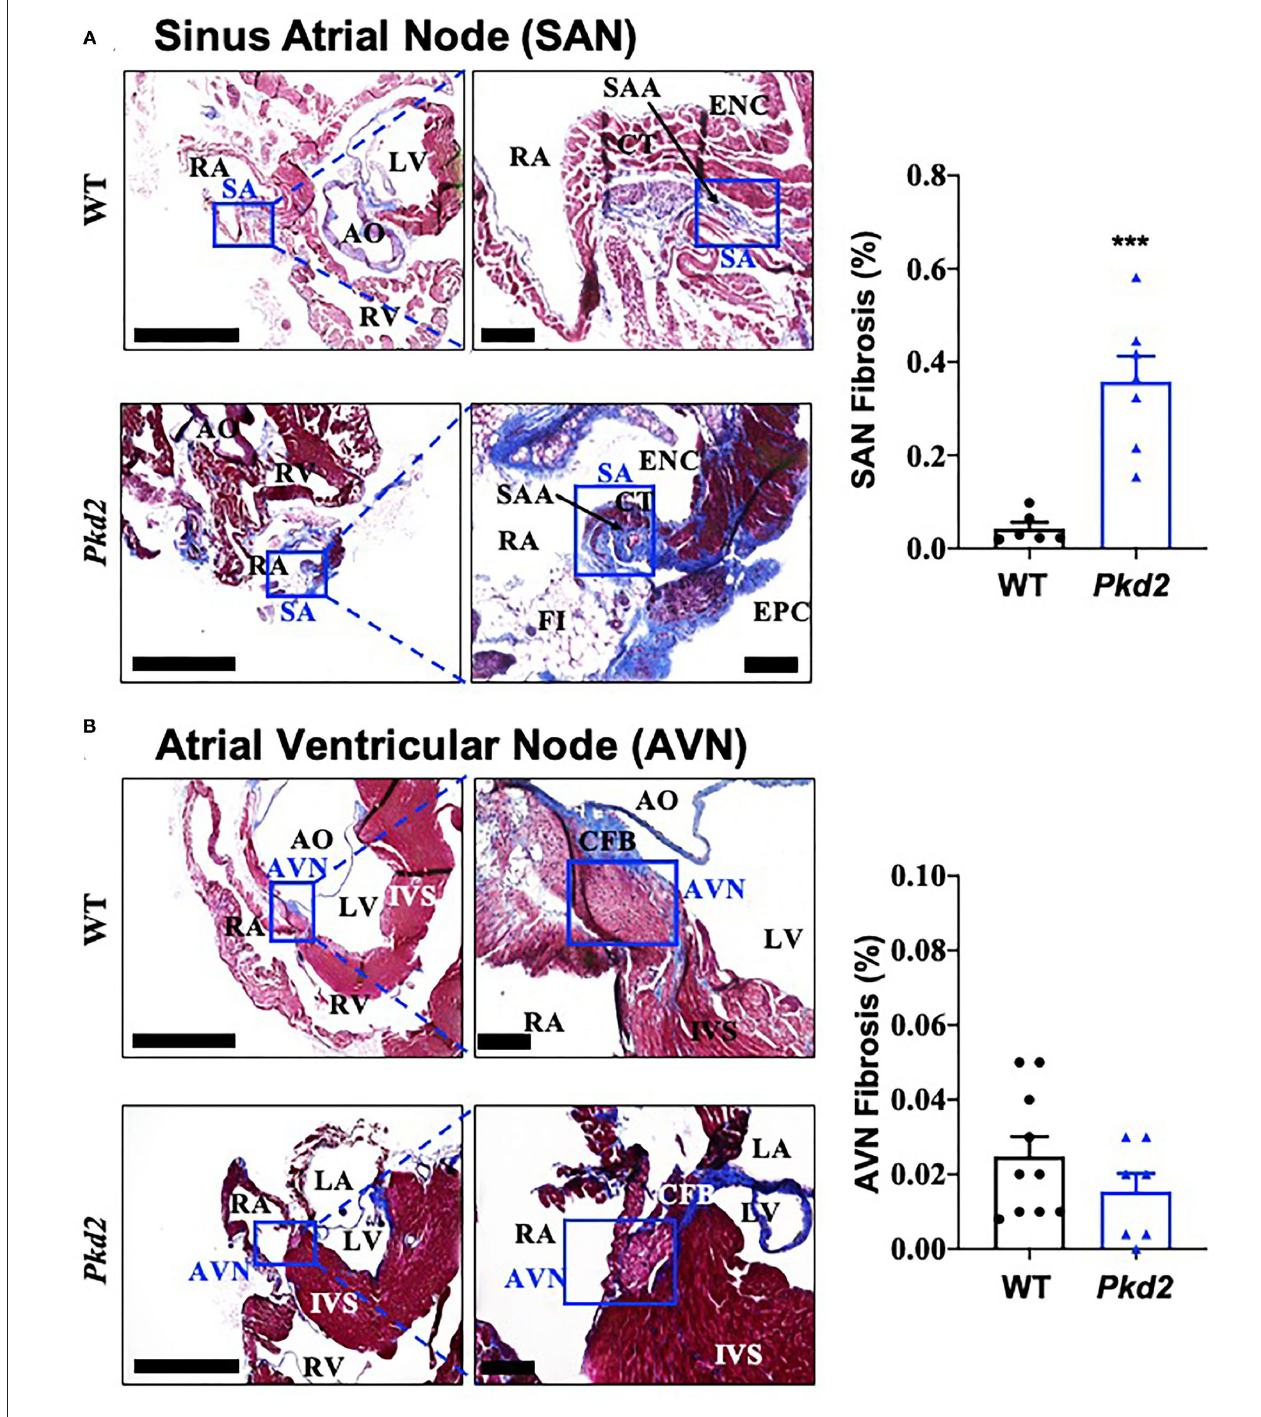
FIGURE 2 | The sinoatrial node (SAN) Pkd2 -KO mice are characterized with fibrosis and fatty infiltration. Masson’s trichrome staining was performed in wild-type (WT) and Pkd2 -KO ( Pkd2 ) mouse hearts. (A) A significant increase of fibrotic tissue is seen in SAN of right atrium in PKD mouse compared to WT. Boxes indicated SAN, and the left panel is further magnified and shown in the right panel. (B) No significant difference of fibrotic tissue is detected in AVN of right atrium in Pkd2 -KO mouse. Boxes indicated AVN, and the left panel is further magnified and shown in the right panel. AO, aorta; AVN, atrioventricular node; CFB, central fibrous body; CT, Crista terminalis; ENC, endocardium; EPC, epicardium; FI, fatty infiltration; IVS, interventricular septum; LV, left ventricle; RA, right atrium; RV, right ventricle; SA, sinoatrial node; SAA, sinoatrial artery. Scale Bar = 20mm. N = 6–10 mice for each WT and Pkd2 -KO group at age matched of 6 months old. *** p < 0.001.